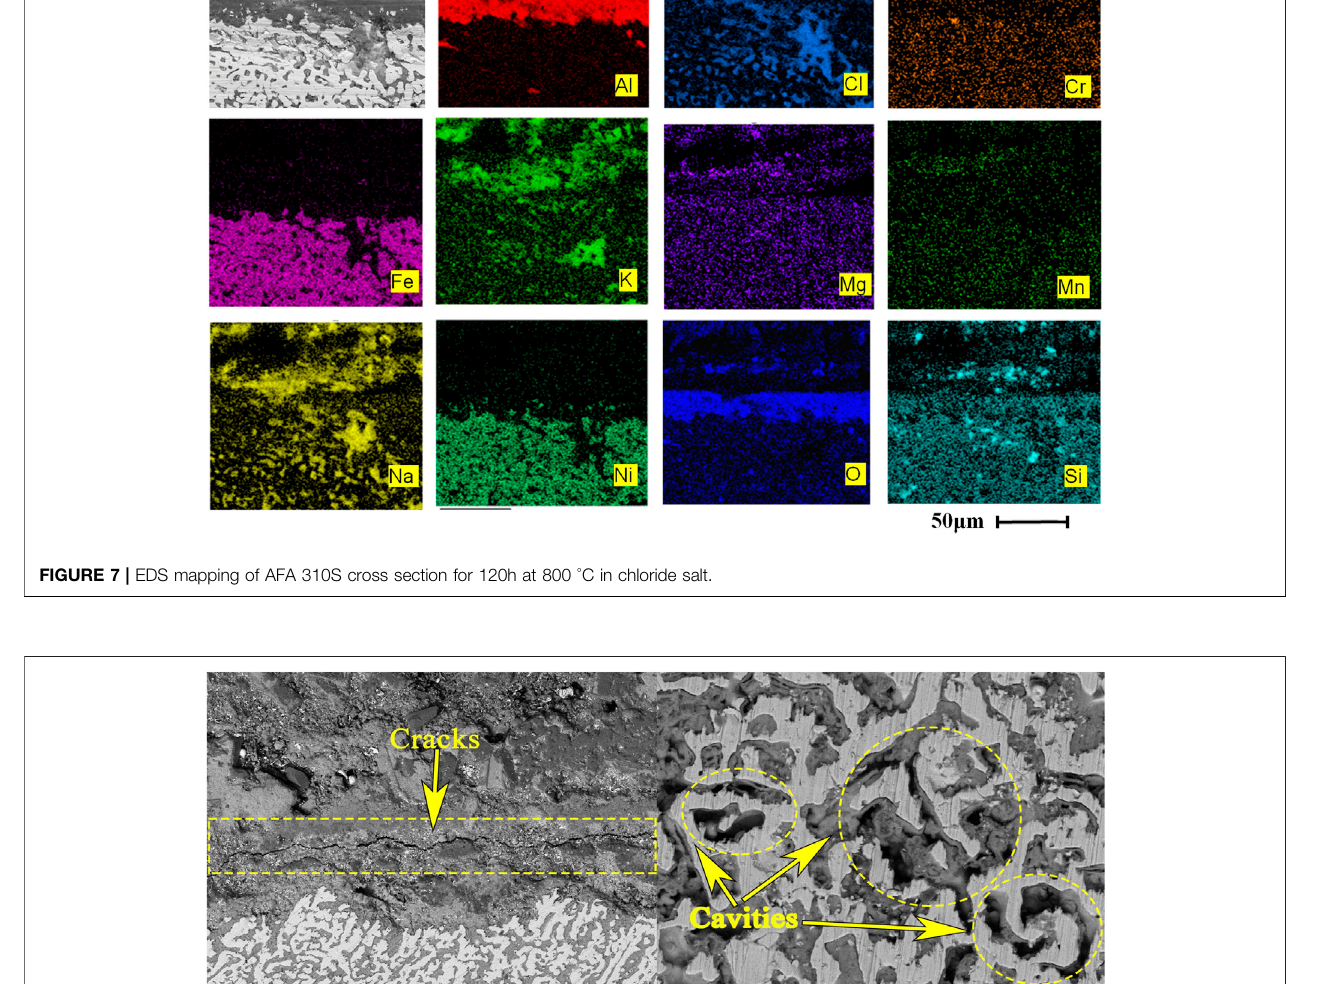
Frontiers in Materials |